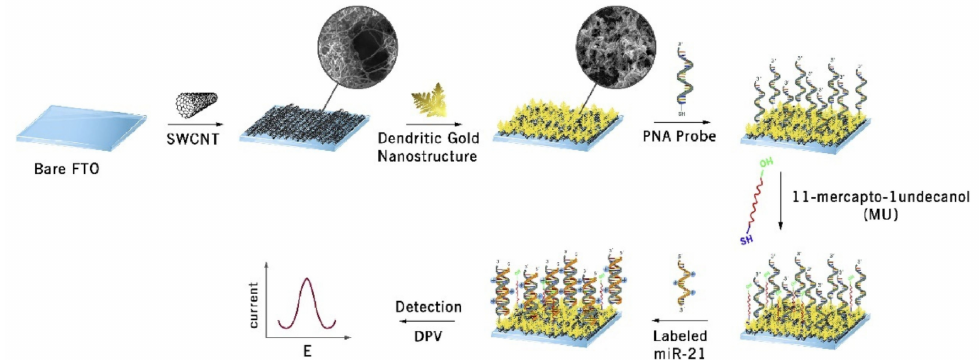
Figure 3. Schematic presentation of the various steps involved in biosensor modification with single-walled carbon nanotubes (SWCNTs) and dendritic gold nanostructure for the electrochemical sensing of miR-21 via differential pulse voltammetry (DPV). Reprinted from [52] with permission from